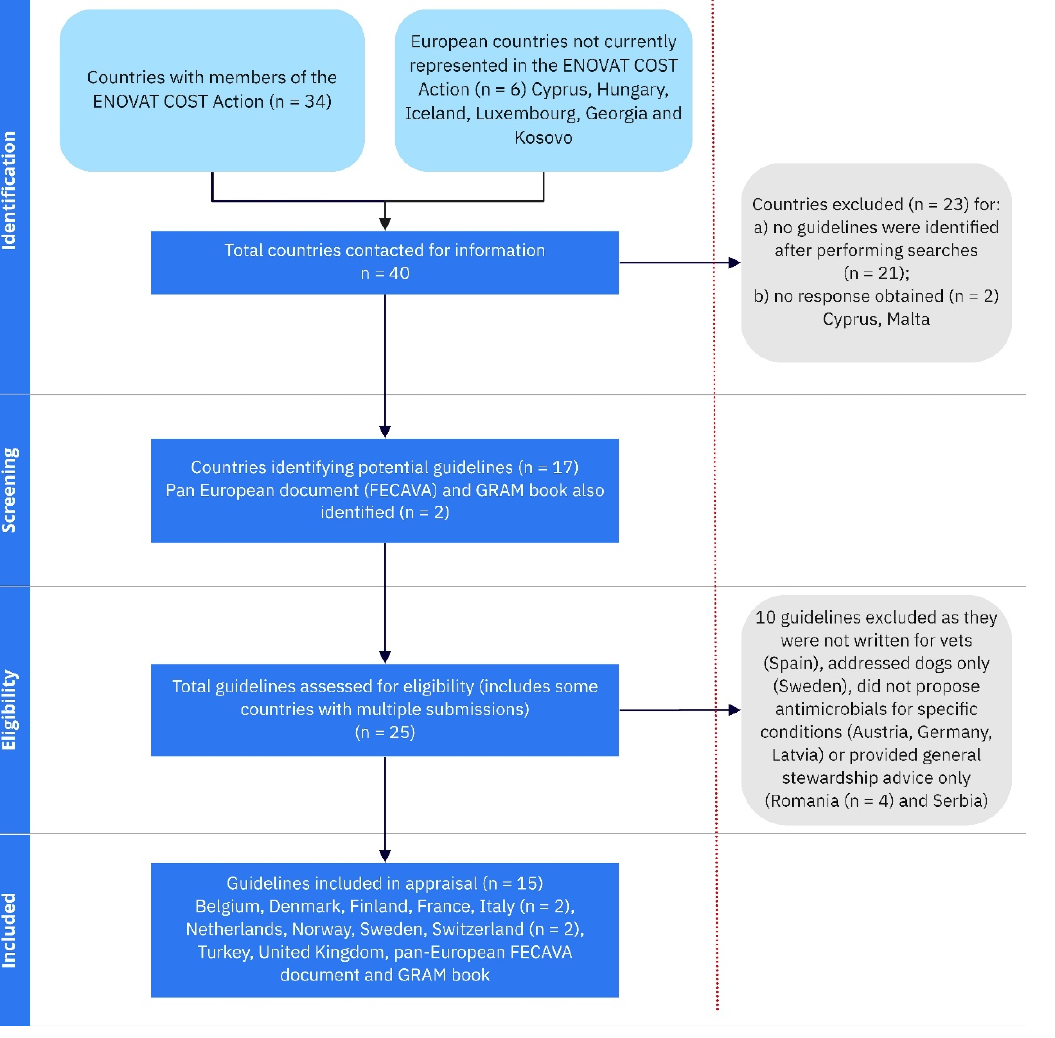
Figure 1. Flow diagram showing the identification, screening and selection of ASGs for detailed review. Excluded ASG are listed in Supplementary Table S1. Table 1. ASGs included in this study. Antimicrobial Stewardship Guidelines (ASGs) Formularium Antimicrobial Consumption and Resistance in Animals (AMCRA)